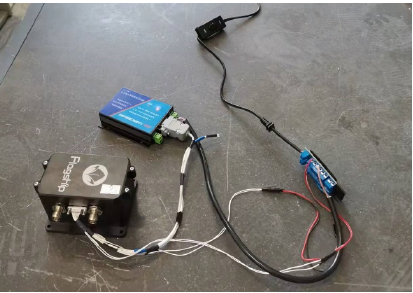
Figure 4. Field experiment diagram of static test.